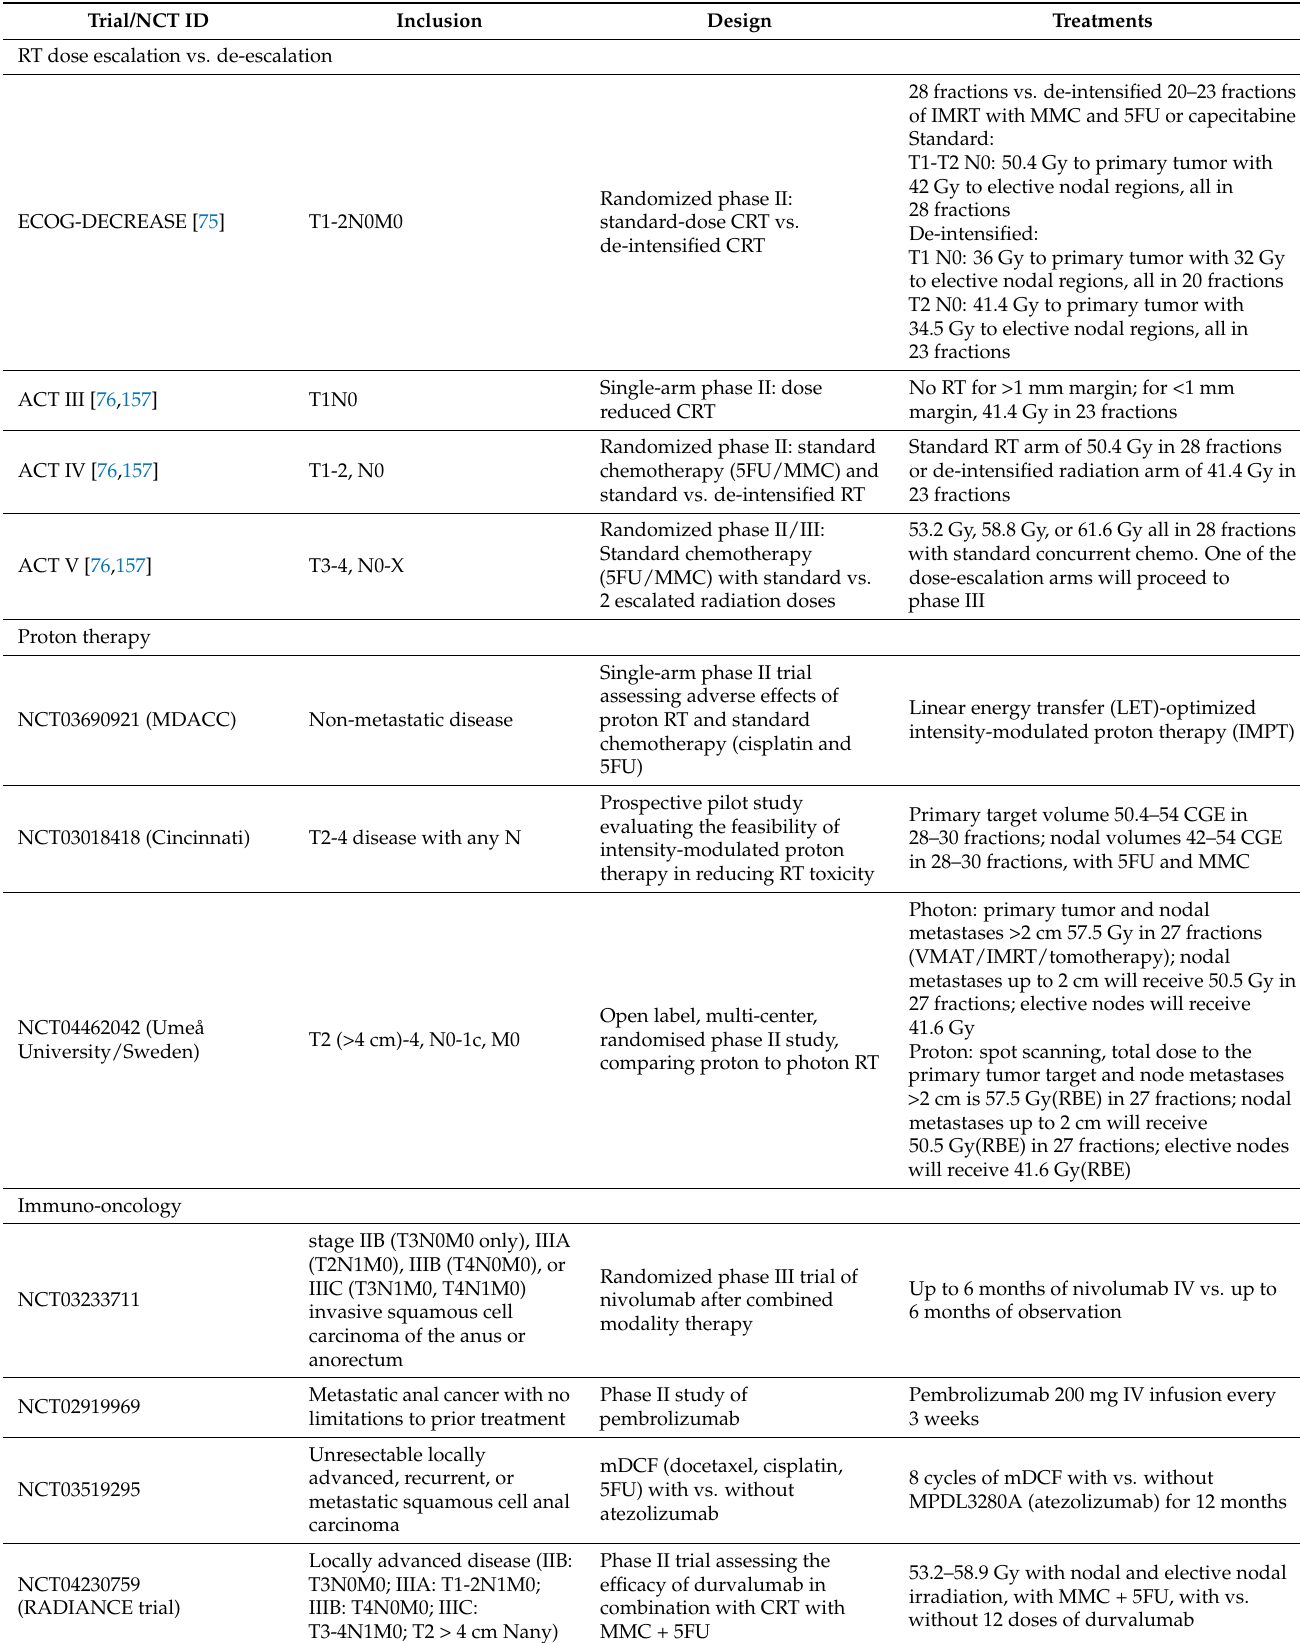
Table 2. Ongoing